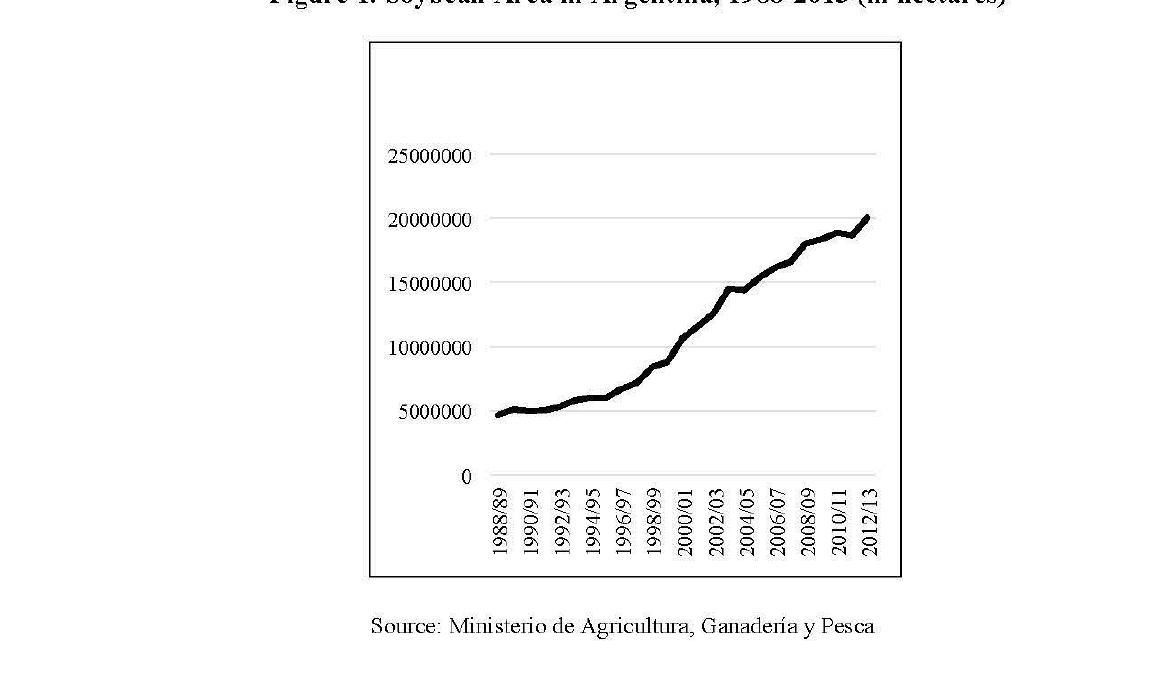
Figure 1. Soybean Area in Argentina, 1988-2013 (in